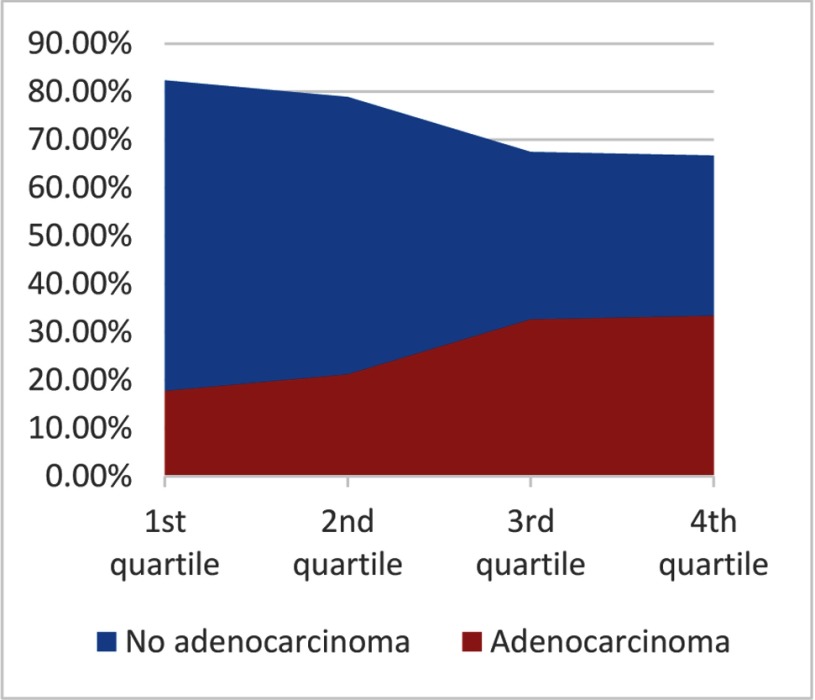
Frequency of carcinoma detection.